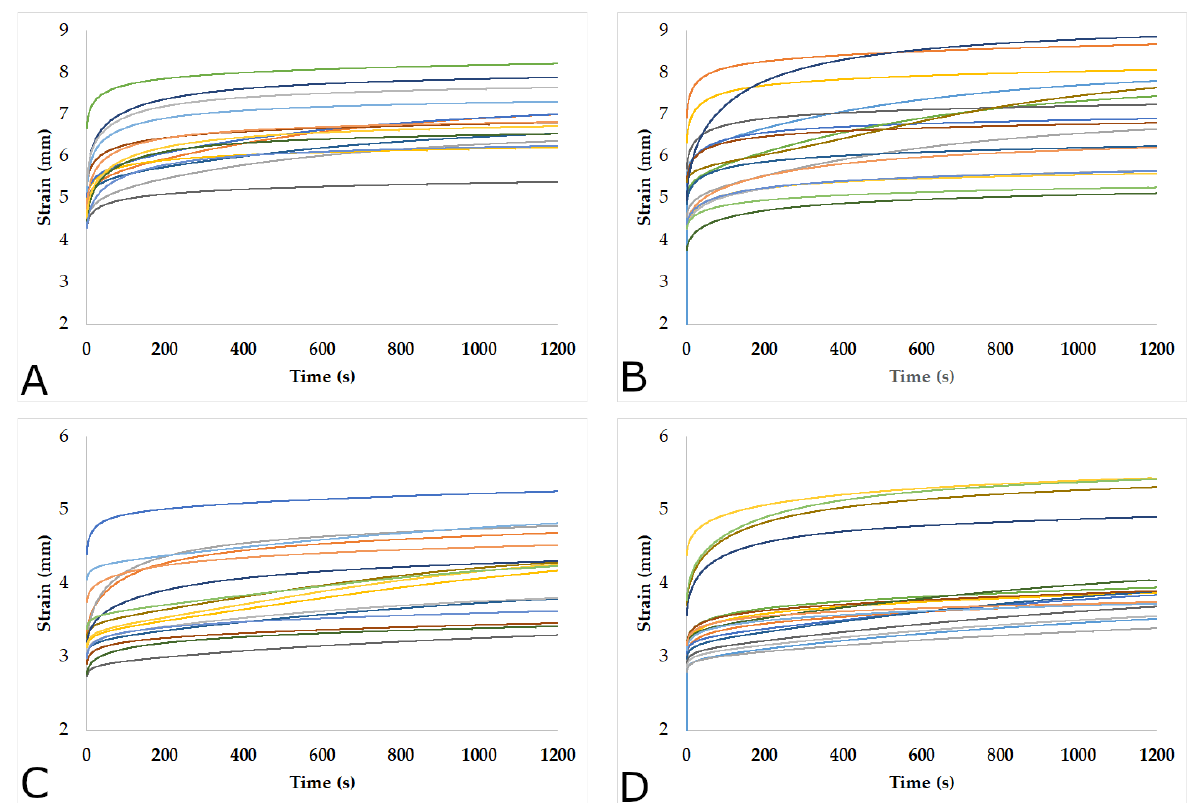
Figure 4. Evolution of the pieces with a density of 0.39 g cm −3 subjected to tensile creep: Load 1530 N: ( A ) tangential; ( B ) radial. Load 1170 N: ( C ) tangential; ( D ) radial.